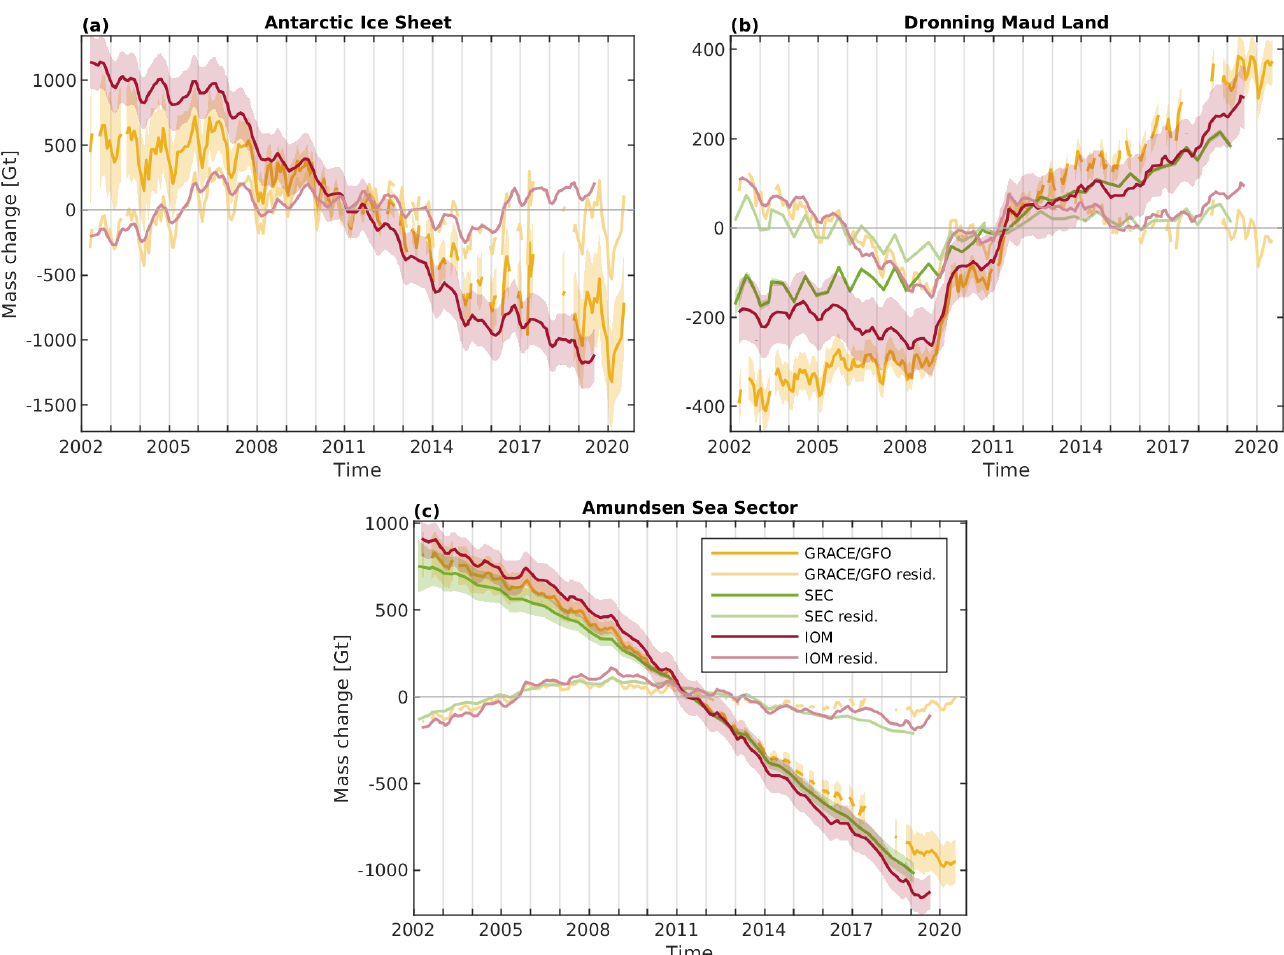
Figure 7. Mass change time series from GRACE/GRACE-FO using tailored sensitivity kernels of variant (ICE,FAR,ANTOC,1.0), from satellite altimetry-derived surface elevation changes (SEC, [61]) and from the input–output- method (IOM, [59]) for ( a ) the entire Antarctic Ice Sheet (AIS), ( b ) Dronning Maud Land (i.e., Basins 05–08) and ( c ) Amundsen Sea Sector (i.e., Basins 21–22). Faint lines indicate the corresponding residuals with respect to the linear trend over the period from 2002-04 through